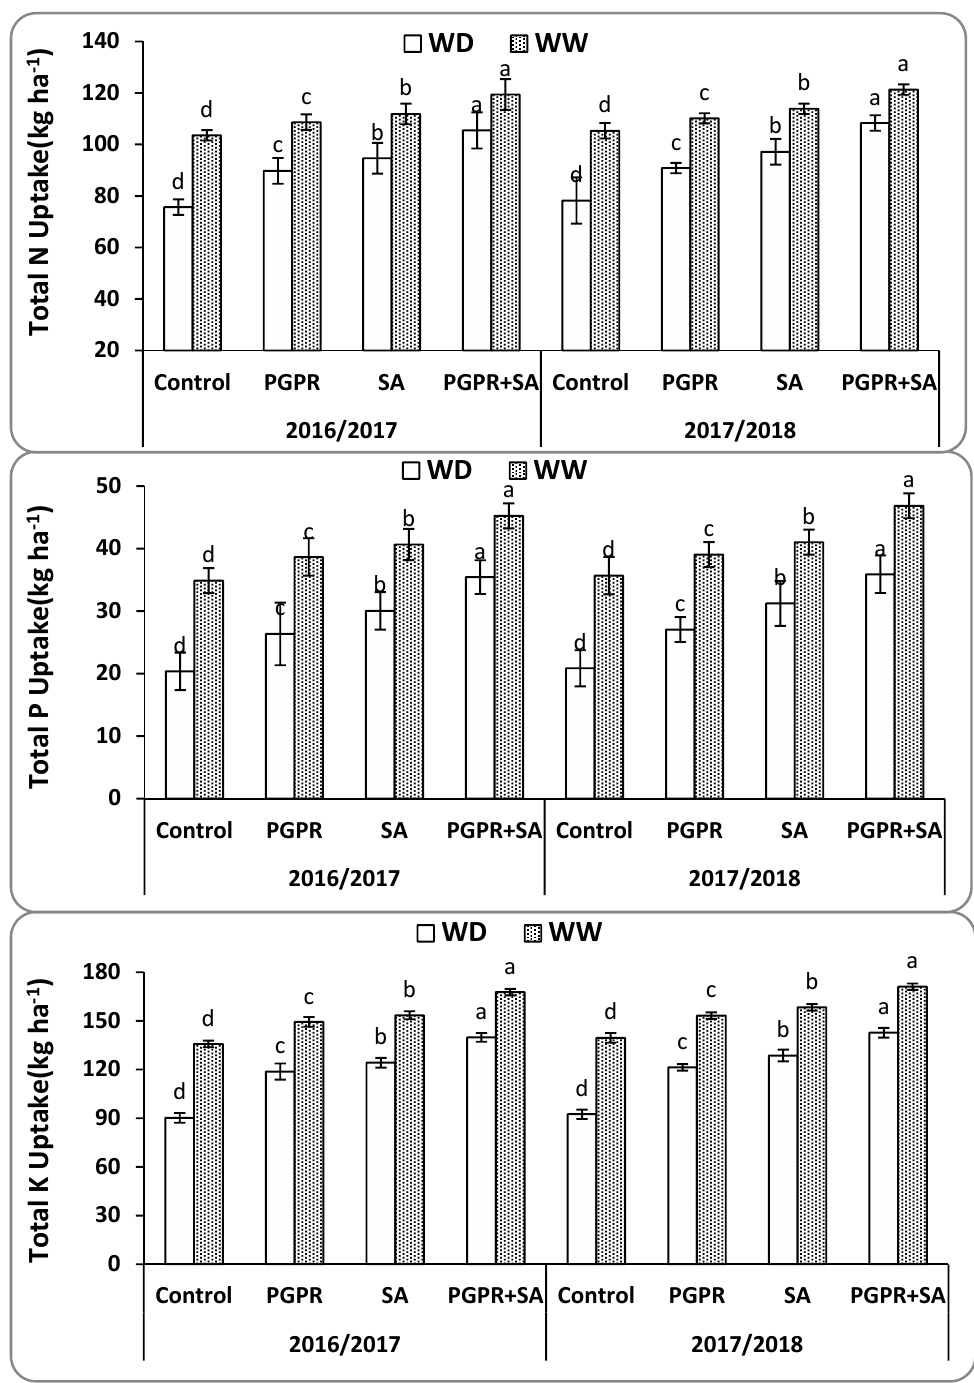
Figure 4. E ff ect of soil and foliar treatments on nitrogen, phosphorus and potassium uptake (Kg ha − 1 ) of wheat plants under water deficit conditions during two growing seasons 2016 / 2017 and 2017 / 2018. WD = water deficit (two irrigations), WW = well-watered (four irrigations). The data are the mean ± SE of three replicates; Mean values designed by the same letter in each column are not significant according to Duncan’s Multiple Range